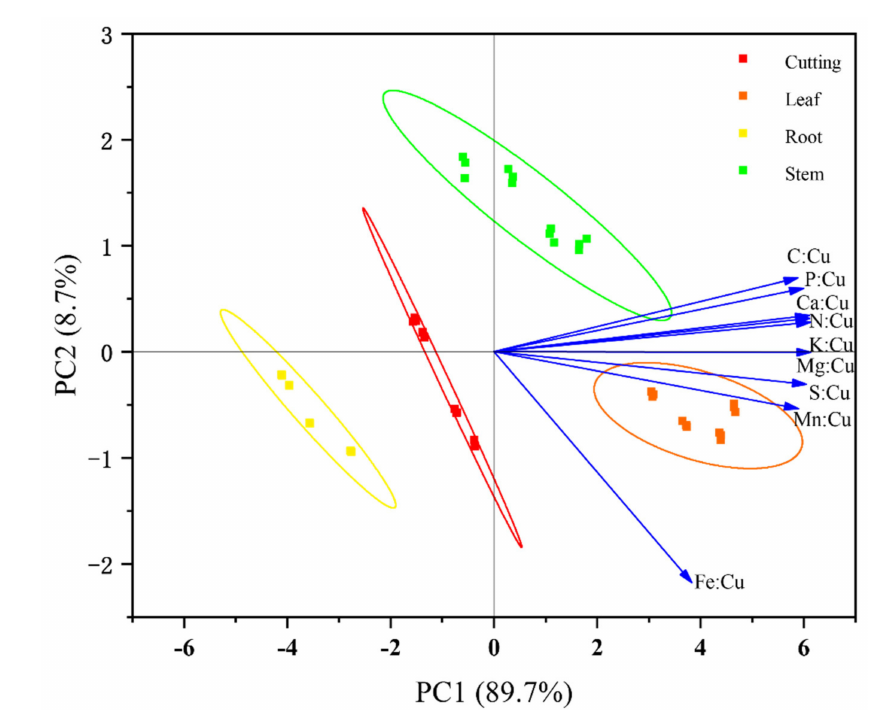
Figure 3. Principal component analysis (PCA) of different element:Cu ratios of the two willows in response to non-flooded and flooded treatments with Cu contamination. The first two principal component scores are